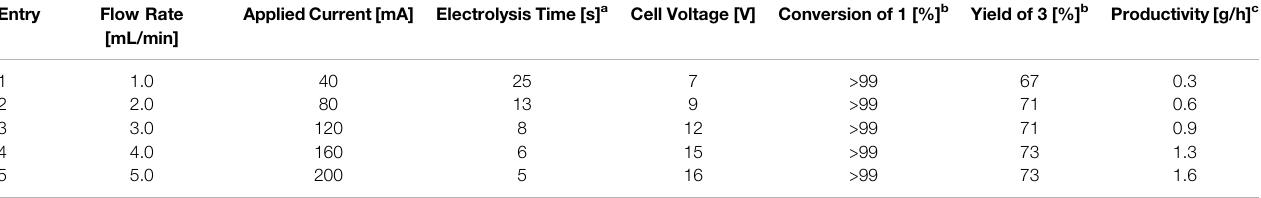
TABLE 4 | Productivity and cell voltage using a fl ow electrochemical reactor